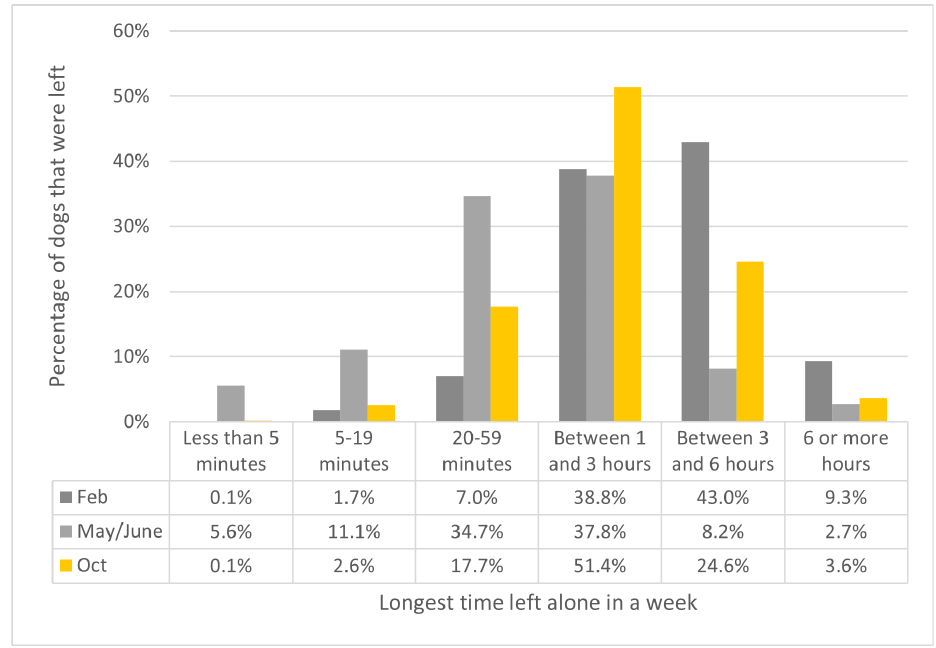
Figure 2. The longest amount of time dogs were left alone, as a percentage of dogs that were left alone in each period.